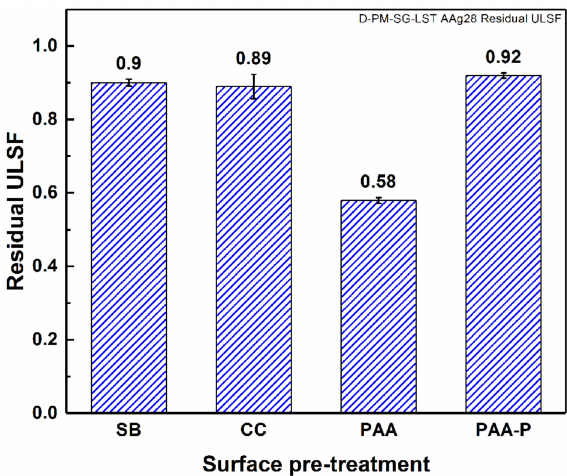
Figure 7. Residual strength of the SLS FSp joints after 28 days of accelerated